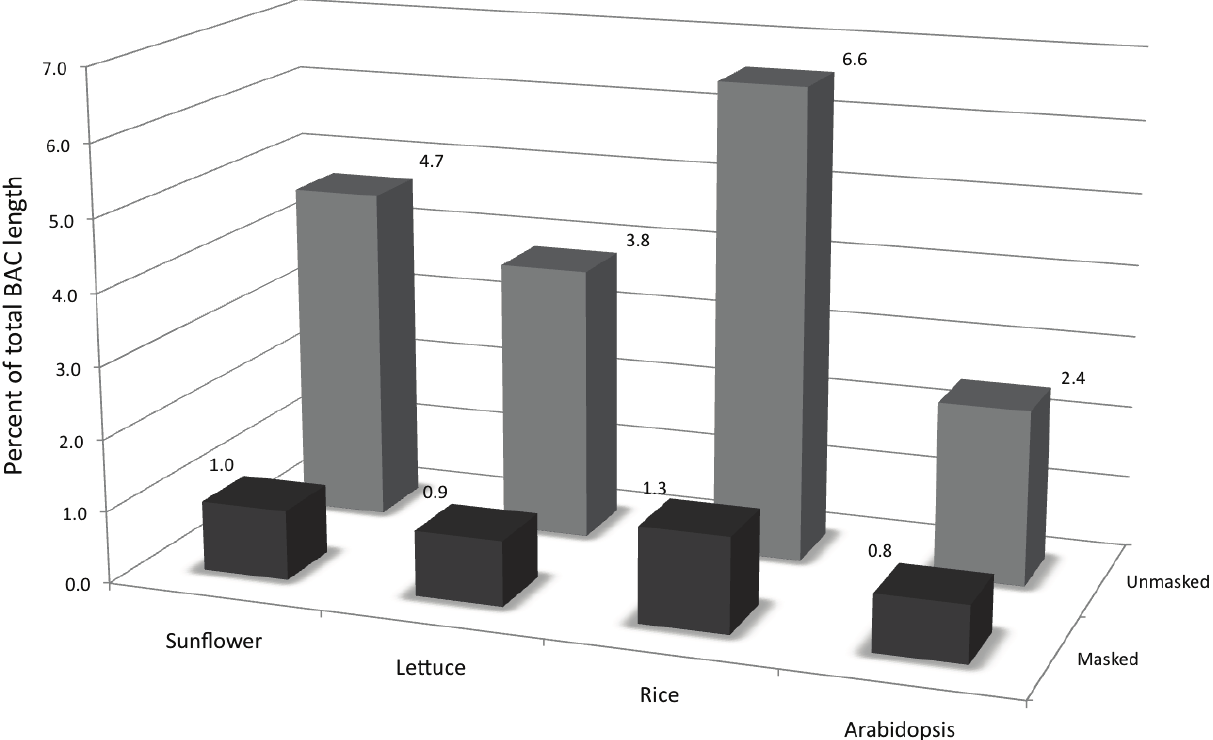
Figure 6. Transcribed portion of the genome as determined by TBLASTX searches of both the repeat-masked and the unmasked datasets against the ESTs of four plant species, two from within Compositae (sunflower and lettuce) and two outside Compositae (rice and Arabidopsis